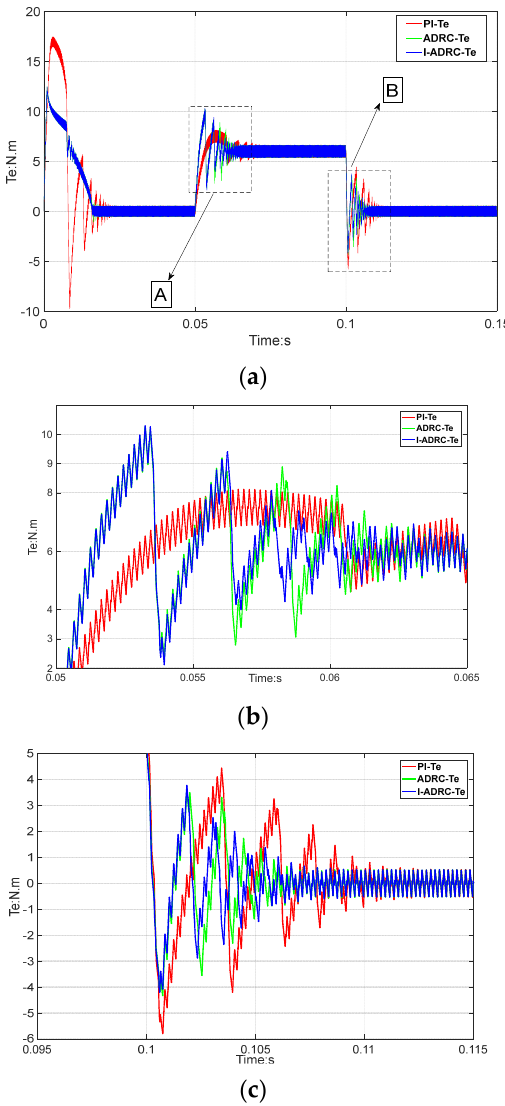
Figure 7. Torque simulation curves: ( a ) complete torque simulation curve, ( b ) partial enlargement A, and ( c ) partial enlargement B.